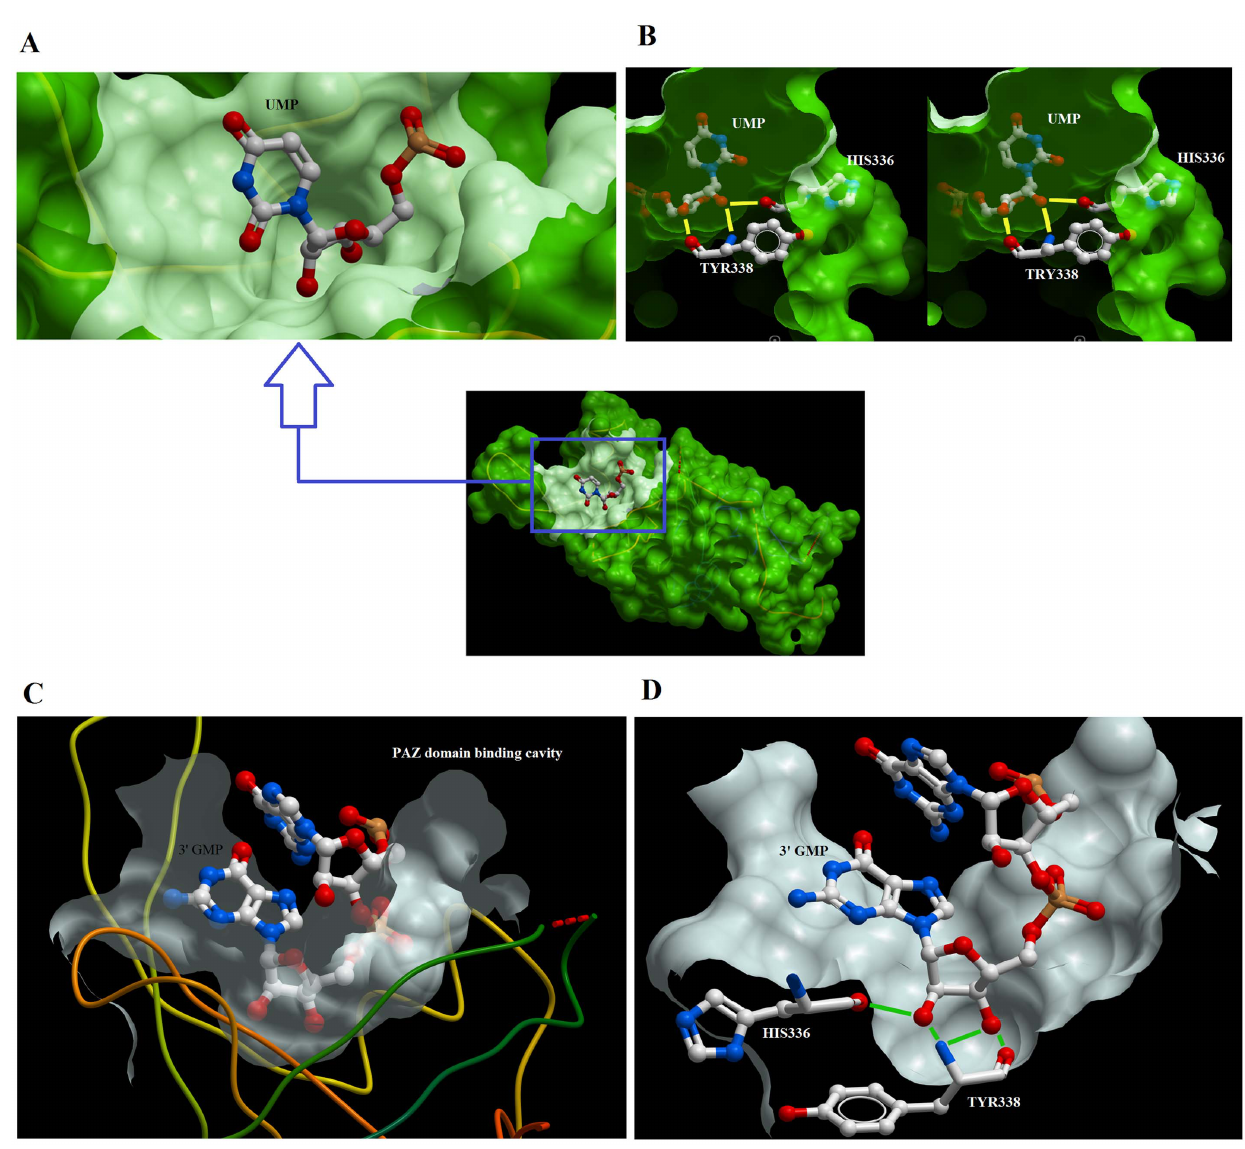
Figure 5. Surface representation of the interaction of nucleotides with PAZ domain of Human Ago2. Accessible surface representation of the human EIF2C2/Ago2 PAZ domain (A) showing the binding cavity of the PAZ domain bound with UMP at its 3 9 -terminal. Stereoview showing the hydrogen bonding of the ribose sugar with the side chains of HIS110 and TYR112 (B). The binding cavity of the EIF2C2/Ago2 PAZ domain bound with GMP at its 3 9 -terminal (C). Hydrogen bonds between the ribose of GMP and the side chains of HIS110 and TYR112 are shown in green (D). The coordinates of interaction were derived from PDB ID 4EI1 and 4F3T. The figure was generated using Molsoft.